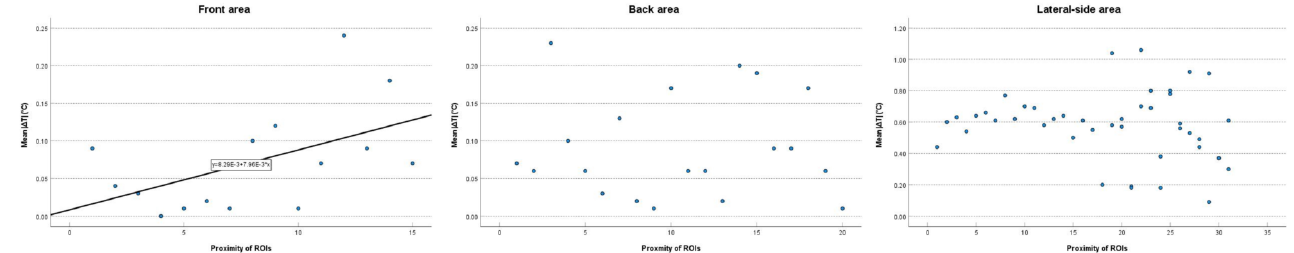
Figure 5. Relation between the absolute values of difference between both sides (| ∆ T|, |right—left|) and the proximity of region of interest in each of the three areas according to regression analysis. | ∆ T| front area = 0.008 + (0.008 × ROIs) ( p = 0.047, R 2 = 0.270); | ∆ T| back area = 0.090 + (9.774 × 10 − 5 × ROIs) ( p = 0.972, R 2 = 0.000); | ∆ T| lateral-side area = 0.645 − (0.004 × ROIs) ( p = 0.327, R 2 = 0.023).